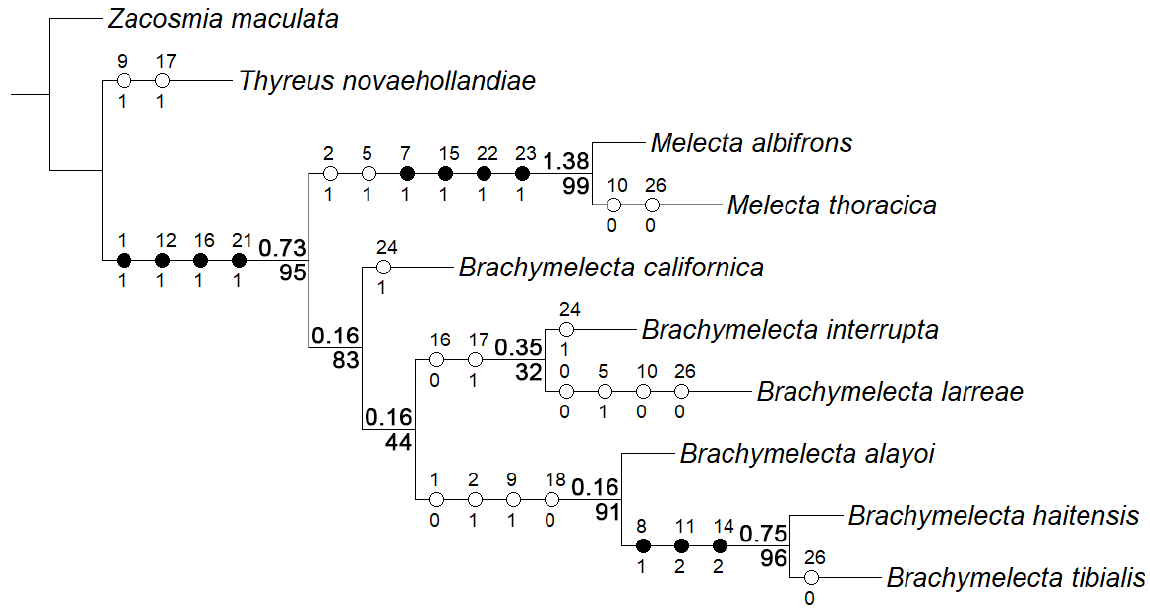
Fig. 17. Fully resolved single most parsimonious tree obtained through maximum parsimony analysis (in TNT) of a combined character set, consisting of 28 morphological characters and DNA barcodes (658 bp, of which 194 were parsimony-informative), with extended implied character weighting. Only morphological characters are shown, with black circles indicating nonhomoplasious changes (autapomorphies or synapomorphies) and empty circles indicating homoplasious changes. Numbers above the circles identify the different characters whereas the numbers below are the assigned character states (see Supp. file 2 for the corresponding descriptions). Numbers to the left of nodes are Bremer support values (above branches) and GC values (below